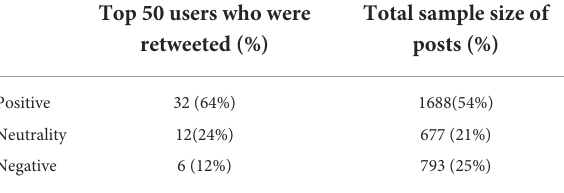
TABLE 4 Basic attributes of the relationship network of COVID-19 vaccine topic posts.